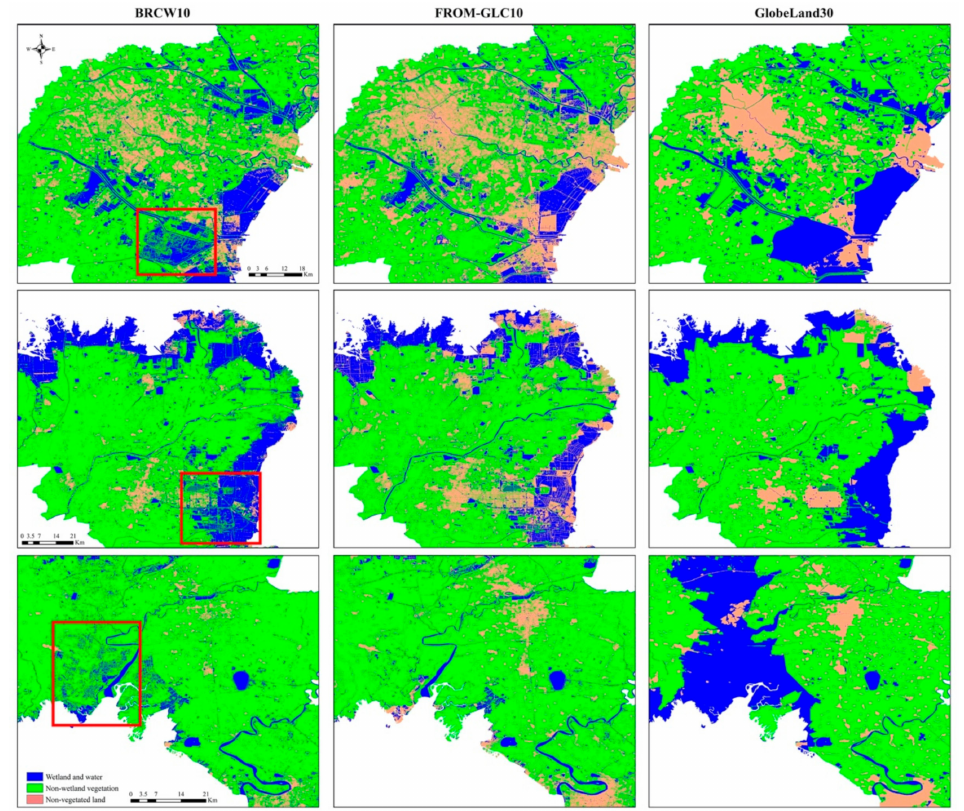
Figure 7. Comparisons of the BRCW10 and corresponding coastal wetlands maps derived from the FROM-GLC10 and the GlobeLand30 data at the Haihe estuary (top row), Yellow River estuary (middle row), and Liaohe estuary (bottom row). The red boxes delineate examples of regions with large di ff erences among the data